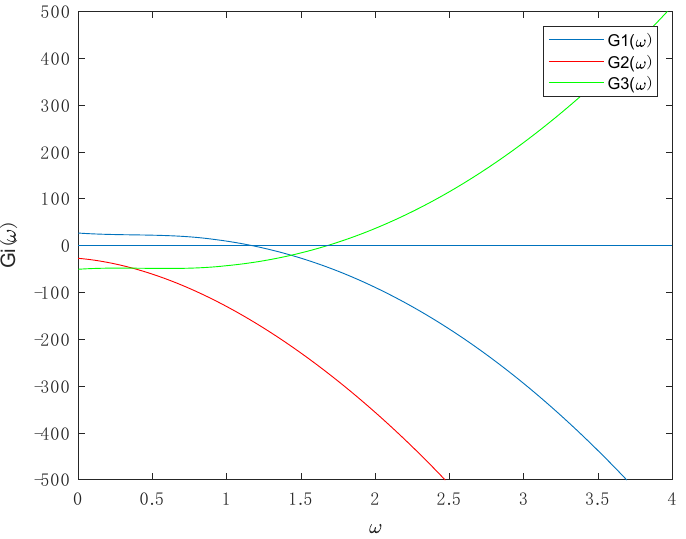
Figure 1. For r 1 = 1, r 2 = 0.1, a = 0.09, b = 0.2, c = 4, η = 0.8, δ = 0.5, G 1 ( ω ) , G 2 ( ω ) , G 3 ( ω ) are all